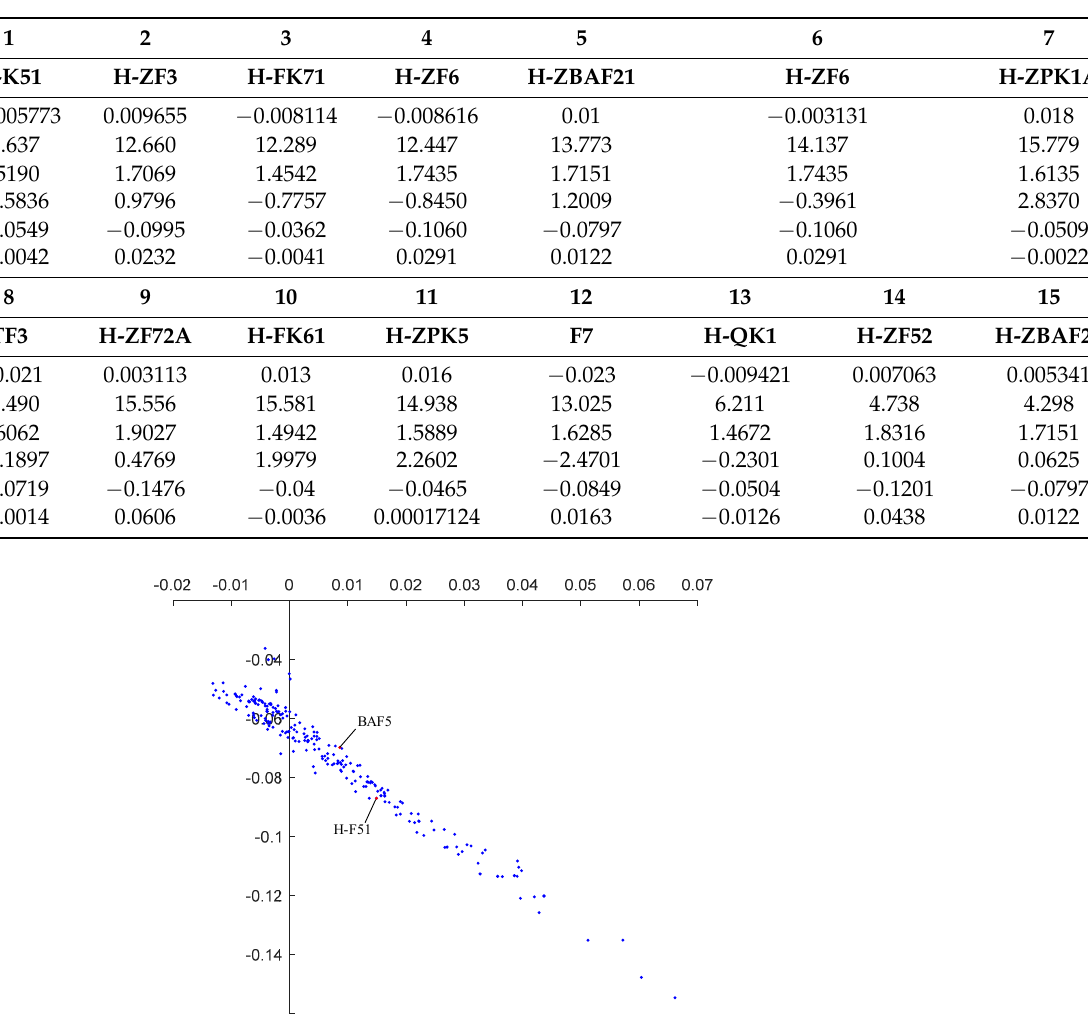
Table 4. Ray-tracing parameters of the optimized system.